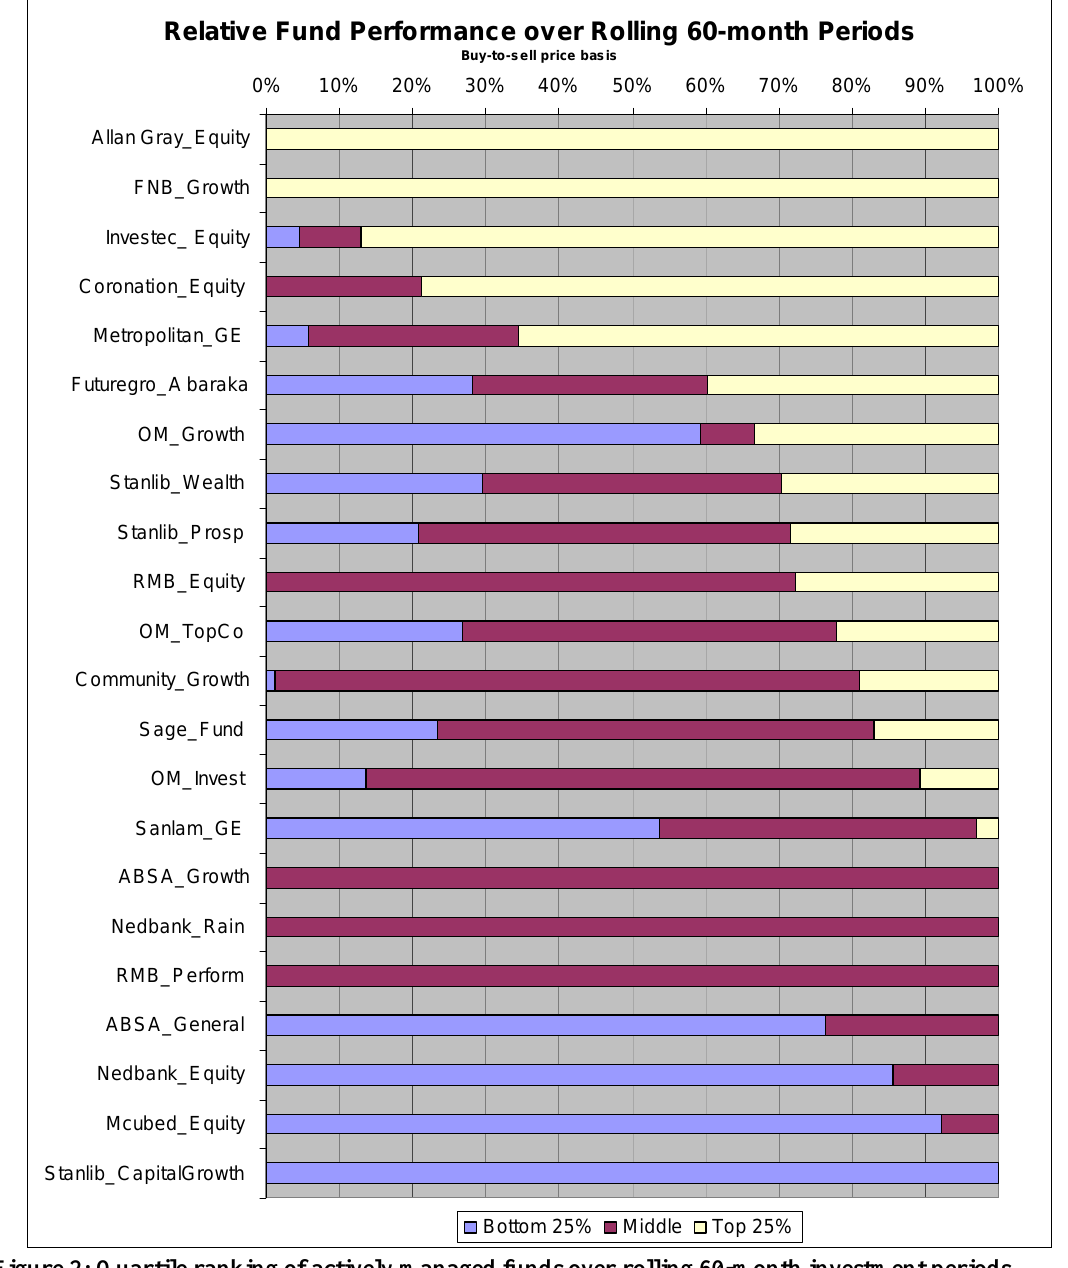
Figure 2: Quartile ranking of actively managed funds over rolling 60-month investment